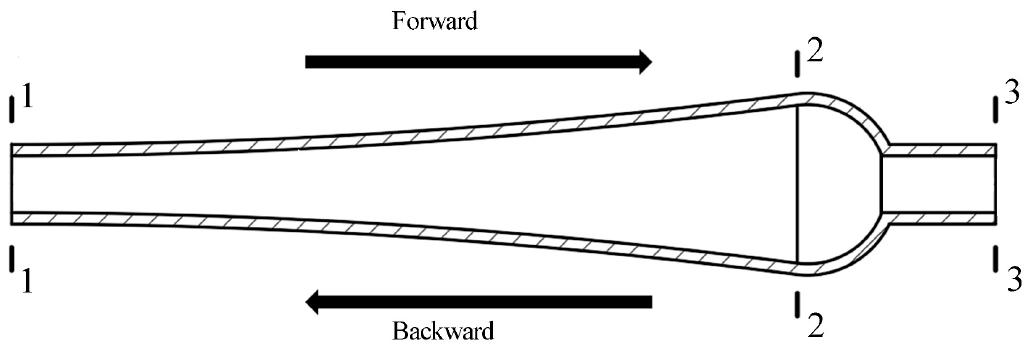
Figure 1. The section view of the streamlined flow tube.